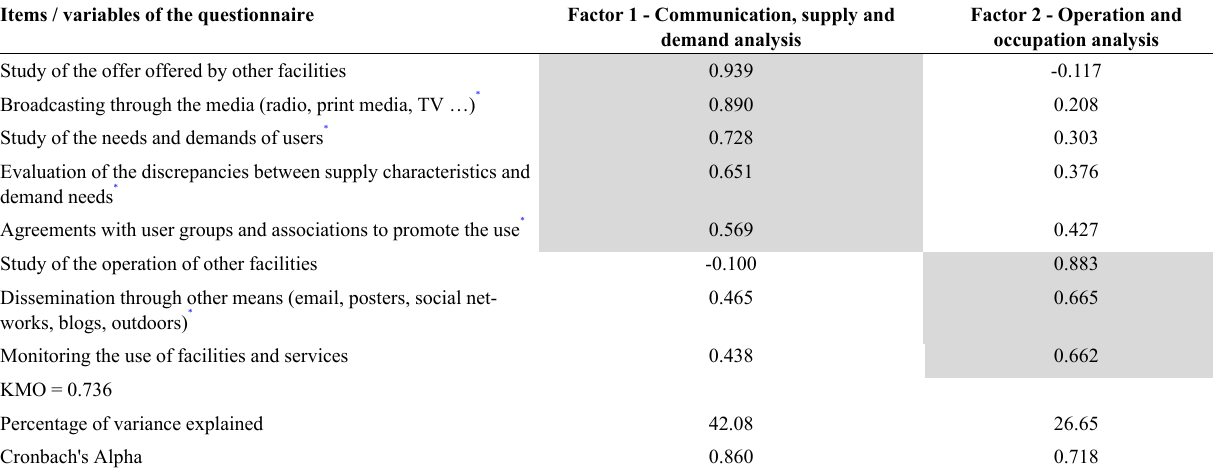
Table 7 - Key components analysis: Marketing and